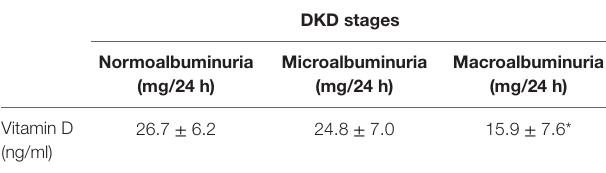
Table 3 | Vitamin D levels and DKD stages in patients with T1DM.